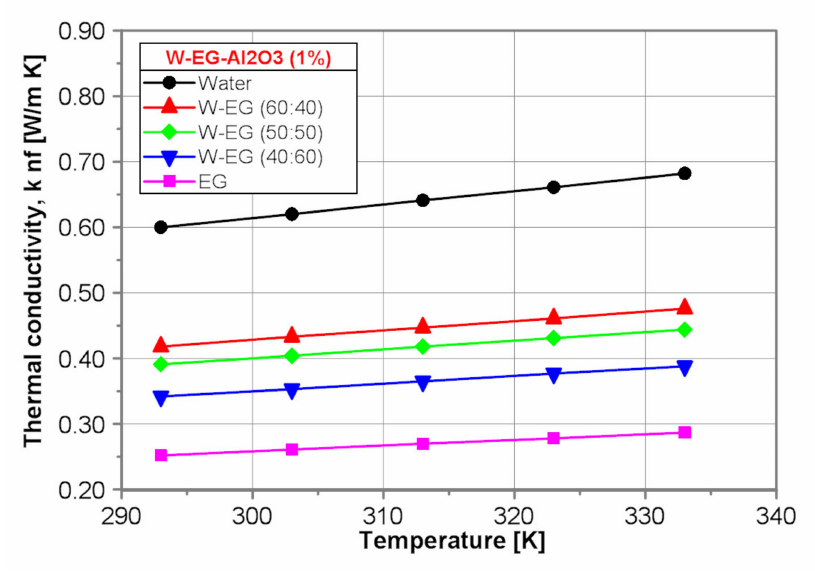
Figure 9. Thermal conductivity of the tested nanofluids.